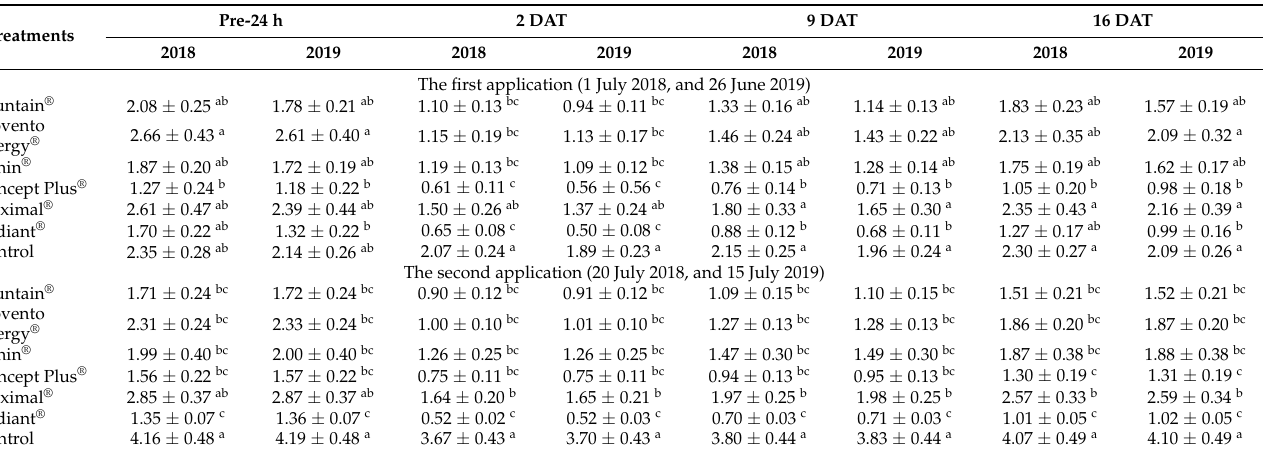
Table 2. Effect of selective insecticides on number (mean ± SEM) of adult thrips per leaf on cot- ton plants during 2018 and 2019. The data were recorded pre-24 h and 2, 9, and 16 days after treatment